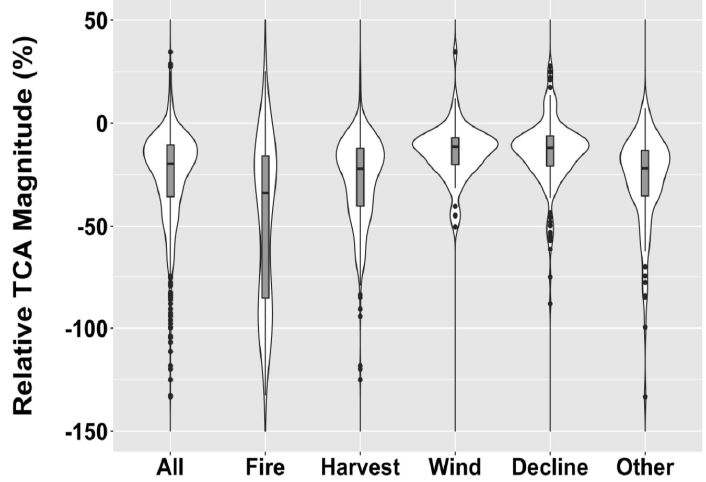
Figure 5. TimeSync reference data summary. Violin plots are based on disturbance occurrence counts across the six study scenes. Note that for subtle disturbances, TCA change values can be expressed in the unexpected direction (i.e., positive values).